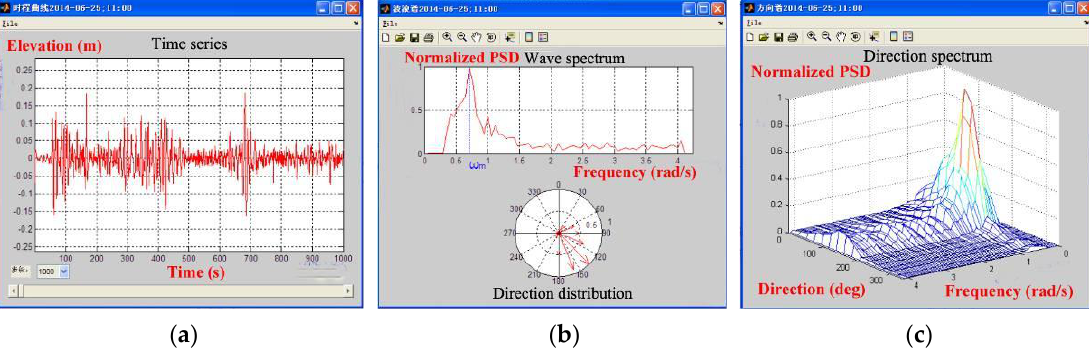
Figure 16. Interface of the 3D wave analysis software: ( a ) time series of wave surface elevation; ( b ) frequency spectrum and direction distribution; and ( c ) directional spectrum.